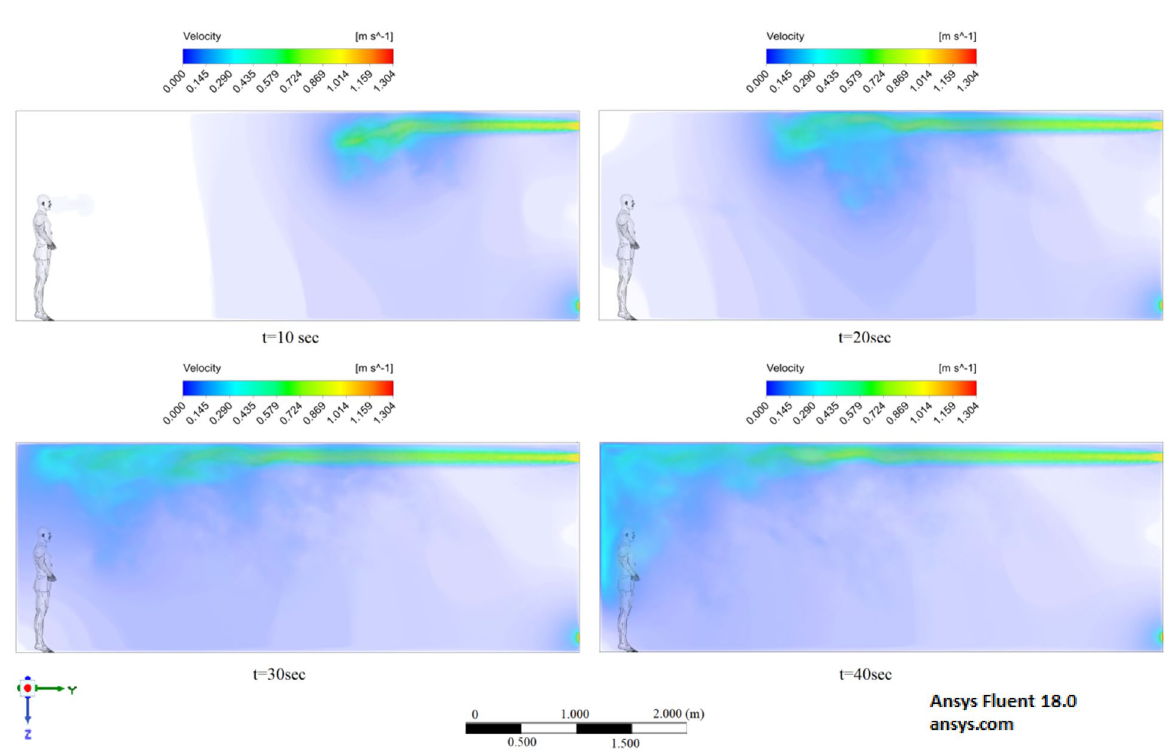
Figure 19. Velocity contours for cough = 6 m/s and ventilation = 1